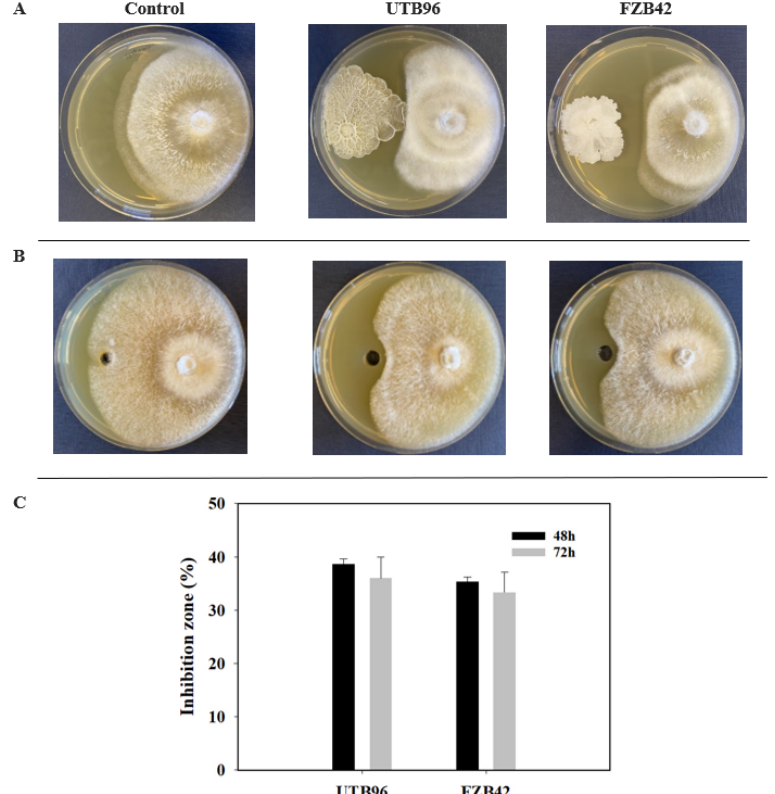
Figure 4. Comparison of antifungal activity; ( A ) cell suspension and ( B ) cell free supernatant taken after 48 and 72 h of B. velezensis strains UTB96 and FZB42 were each co-incubated with the soybean fungal pathogen D. longicolla strain DPC_HOH20 for 5 days. ( C ) The growth inhibitory effect of UTB96 and FZB42 against D. longicolla are summarized in bar graphs. Growth of D. longicolla DPC_HOH20 without the co-incubated B. velezensis strain was used as a control. Each treatment was repeated three times, while the approach was repeated thrice.